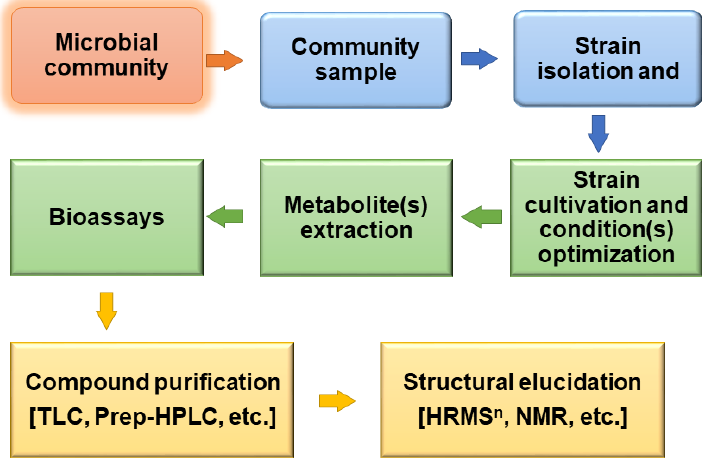
Figure 1. A typical workflow for conventional bioprospecting and drug discovery.